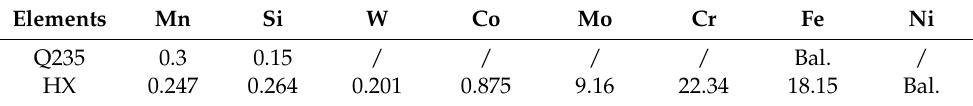
Table 1. The main elemental compositions of Q235 steel and HX wire (wt.%).